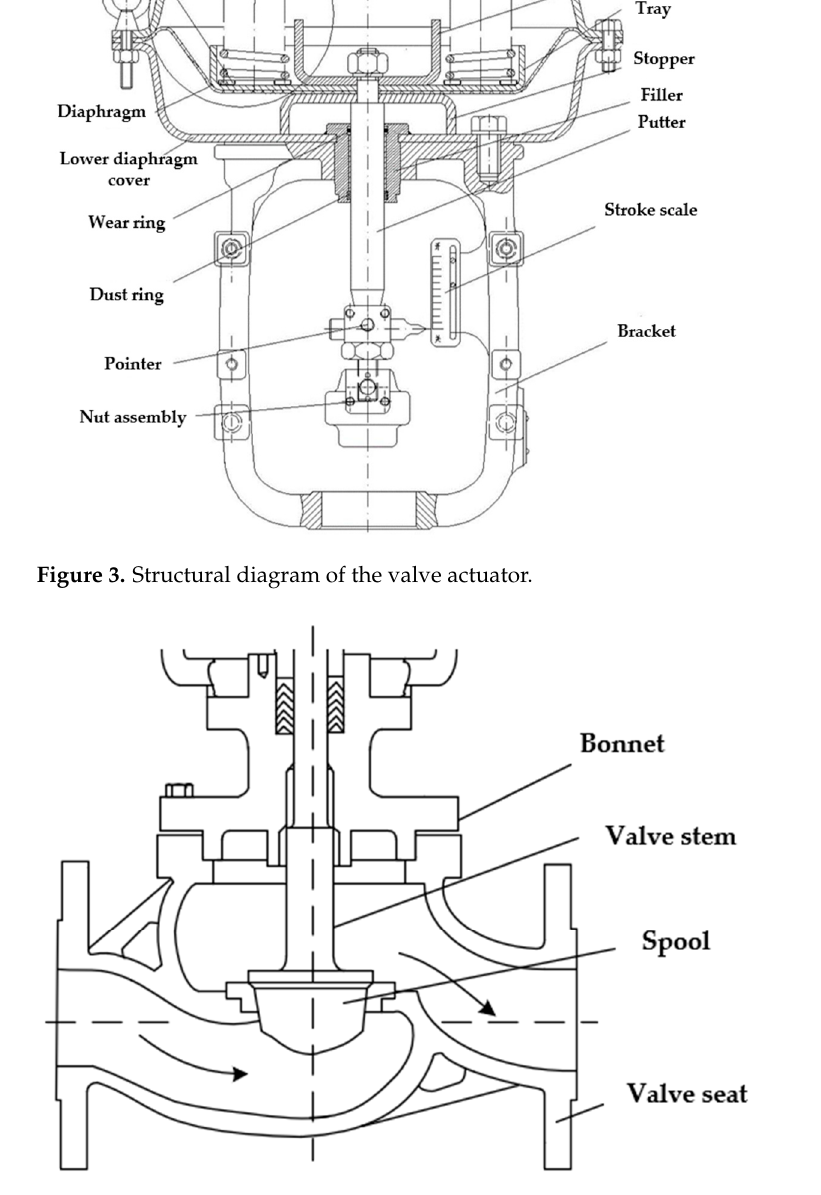
Figure 4. Structural diagram of the control valve body.